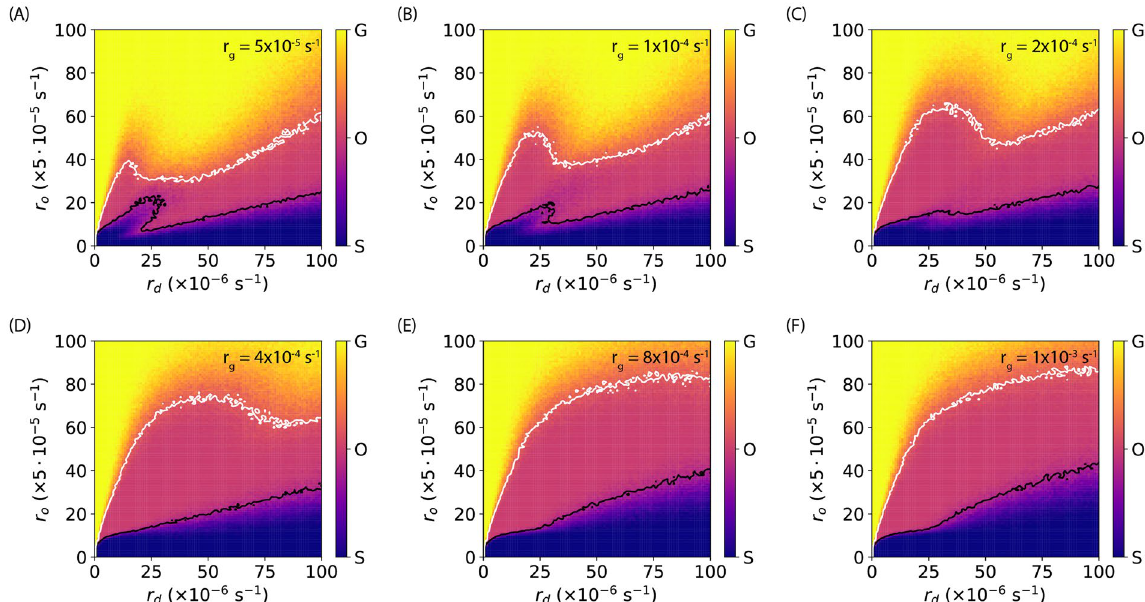
Figure 5. Phase diagrams (the ousting rate r o vs . the damaging rate r d ) of our model at different growth rates, ( A ) r g = 5 × 10 − 5 s − 1 , ( B ) r g = 1 × 10 − 4 s − 1 , ( C ) r g = 2 × 10 − 4 s − 1 , ( D ) r g = 4 × 10 − 4 s − 1 , ( E ) r g = 8 × 10 − 4 s − 1 , and ( F ) r g = 1 × 10 − 3 s − 1 . The white and black curves in ( A–F ) correspond to contour levels of 1.2 and 0.8, respectively. The legends on the color bars read as the following: G = growth, O = oscillation, and S =